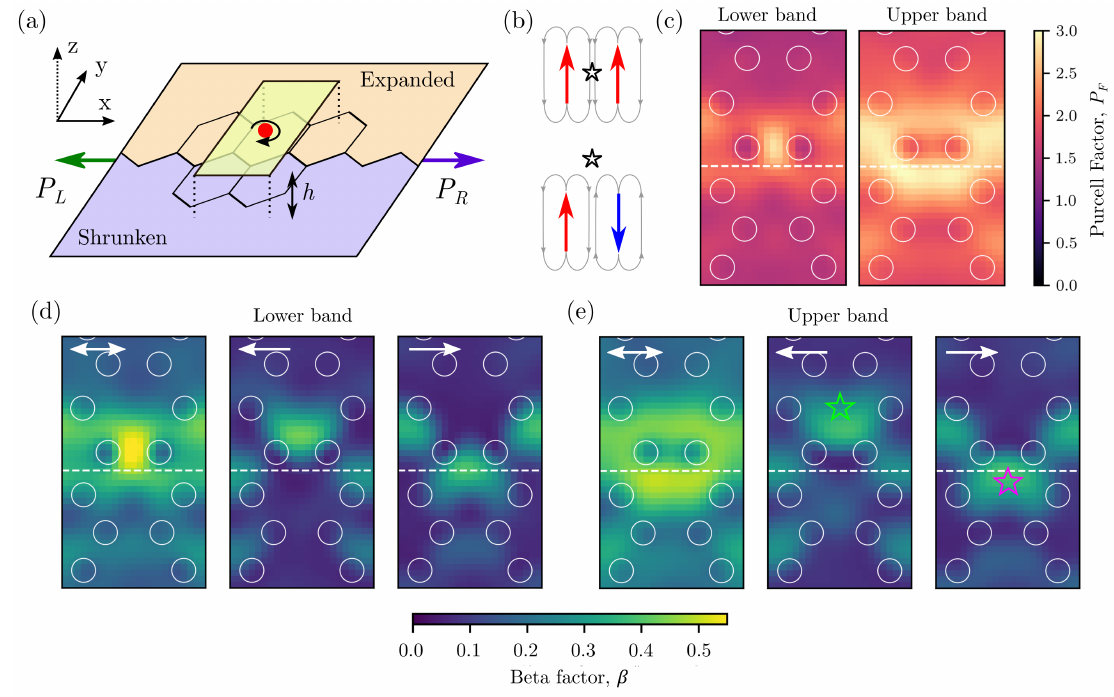
Figure 3. Single sources for varying xy -position across the interface and fixed height h = 30 nm. ( a ) Schematic showing the interface and source layout. ( b ) Hybridisation of out-of-plane dipole moments in NPs for the the bonding upper band ω = 2.795 eV ( above ) and anti-bonding lower band ω = 2.76 eV ( below ). The maximum electric field is at the star in each case. ( c ) Purcell factors, for lower ( left ) and upper ( right ) bands. Beta factors for the ( d ) lower and ( e ) upper band. Left panels β edge , power coupling into the edge, middle panels β L , power coupling into the left and right panels β R , power coupling into the right